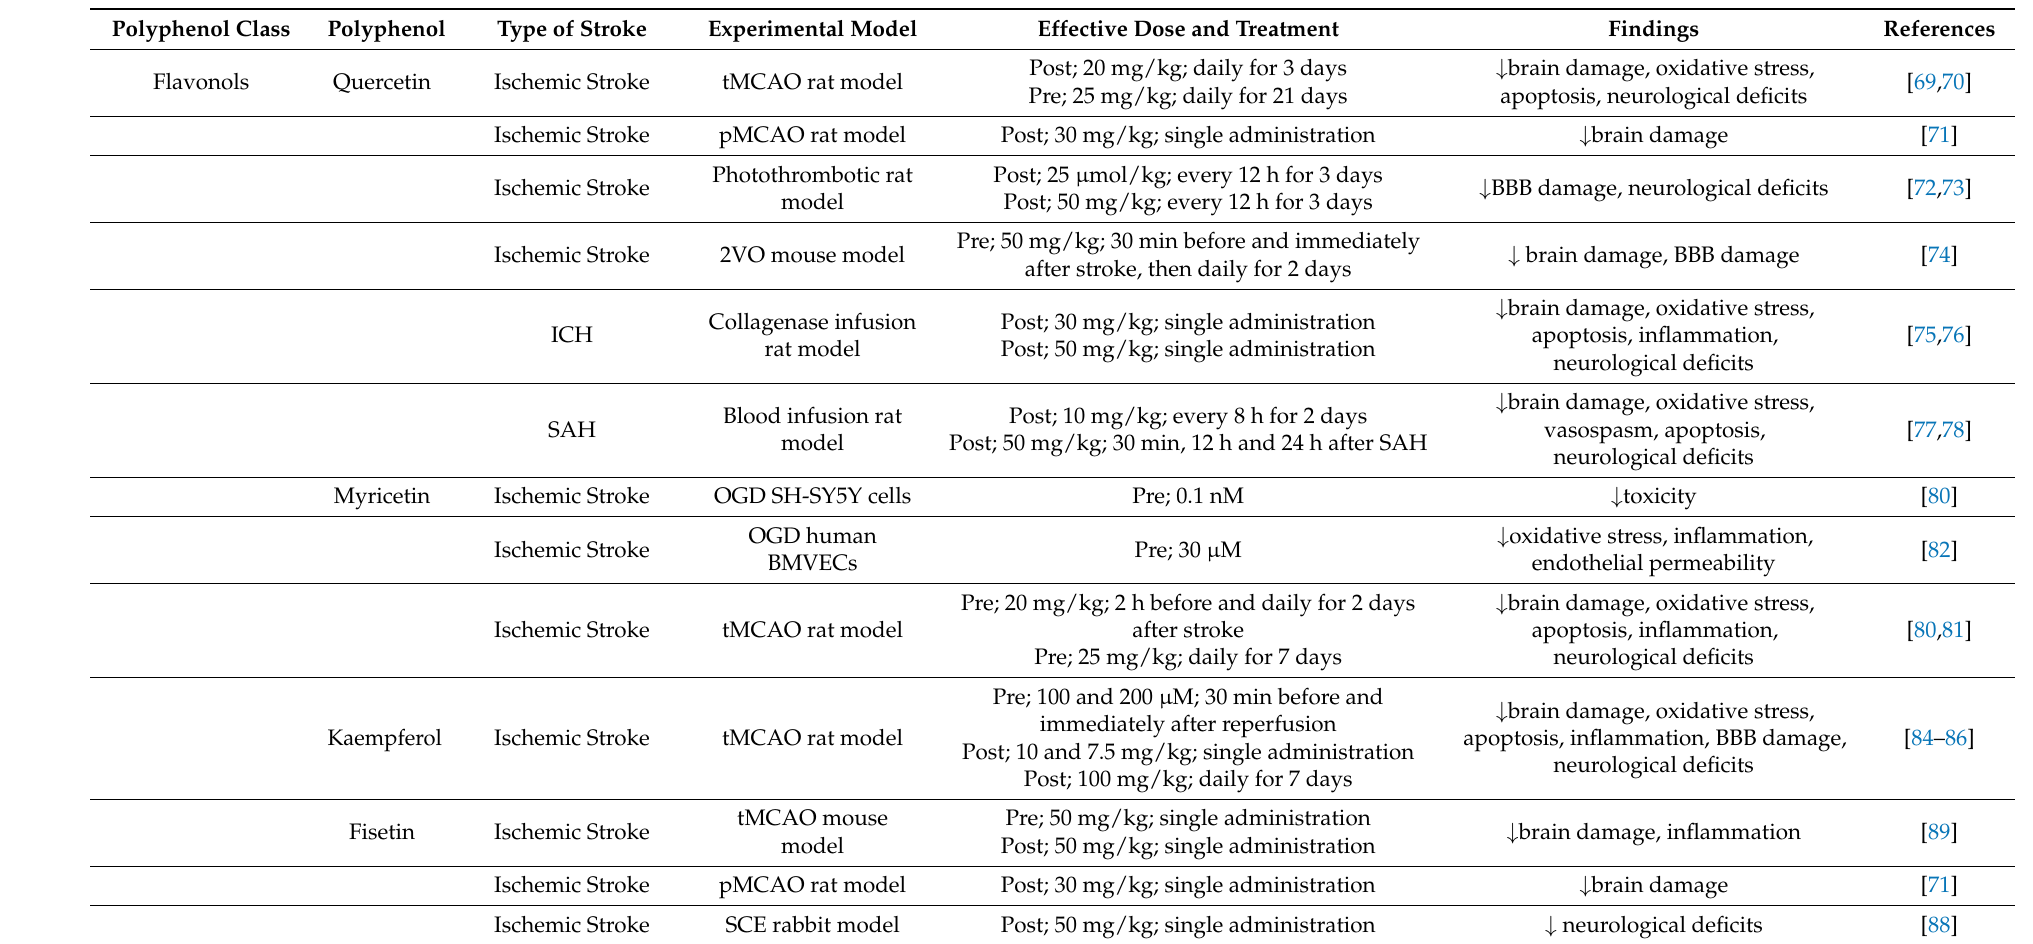
Table 1. Polyphenols active in preclinical stroke